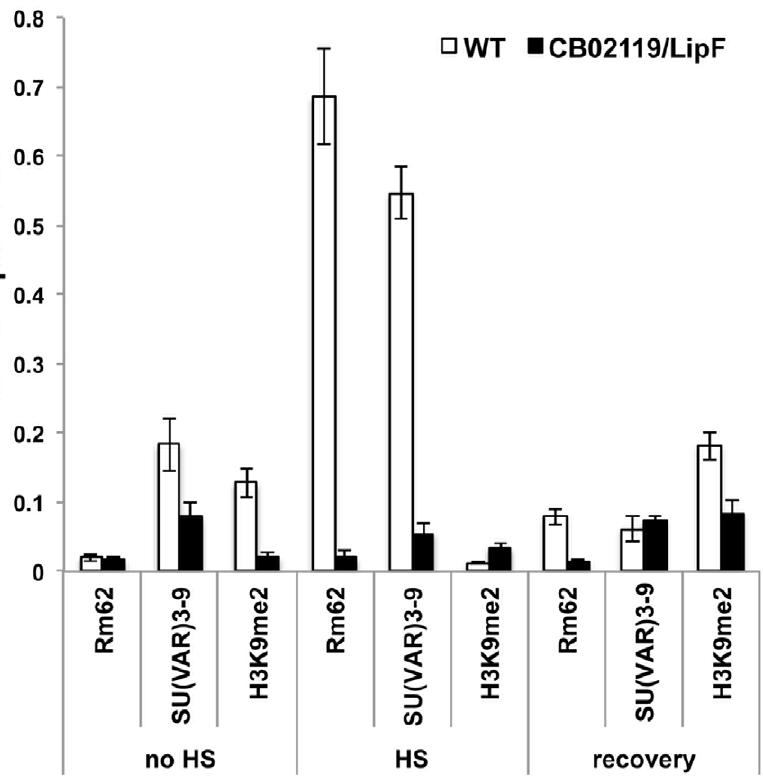
Figure 5. Binding of Rm62, SU(VAR)3-9 and H3K9me2 before, during and after heat shock. Chromatin immunoprecipitation comparing the binding of Rm62, SU(VAR)3-9 and H3me2K9 on the hsp70 promoter was assayed in third instar larvae of wild type (white bars) and heteroallelic Rm62 ( CBO2119/Lip F ) mutant strains (dark bars) either without heat shock (no HS), heat incubation of larvae at 37 u C for 45 min (HS) and 3 hrs after heat treatment (recovery) . The enrichment of proteins for each amplicon of the hsp70 locus was measured relative to the input material. The relative ratios from three independent experiments were depicted as an individual bar. For quantitation, the bands were analyzed using the Odyssey Imaging System (LI-COR Biosciences) system and expressed of percent of input DNA. Error bars indicate the standard deviation of three biological